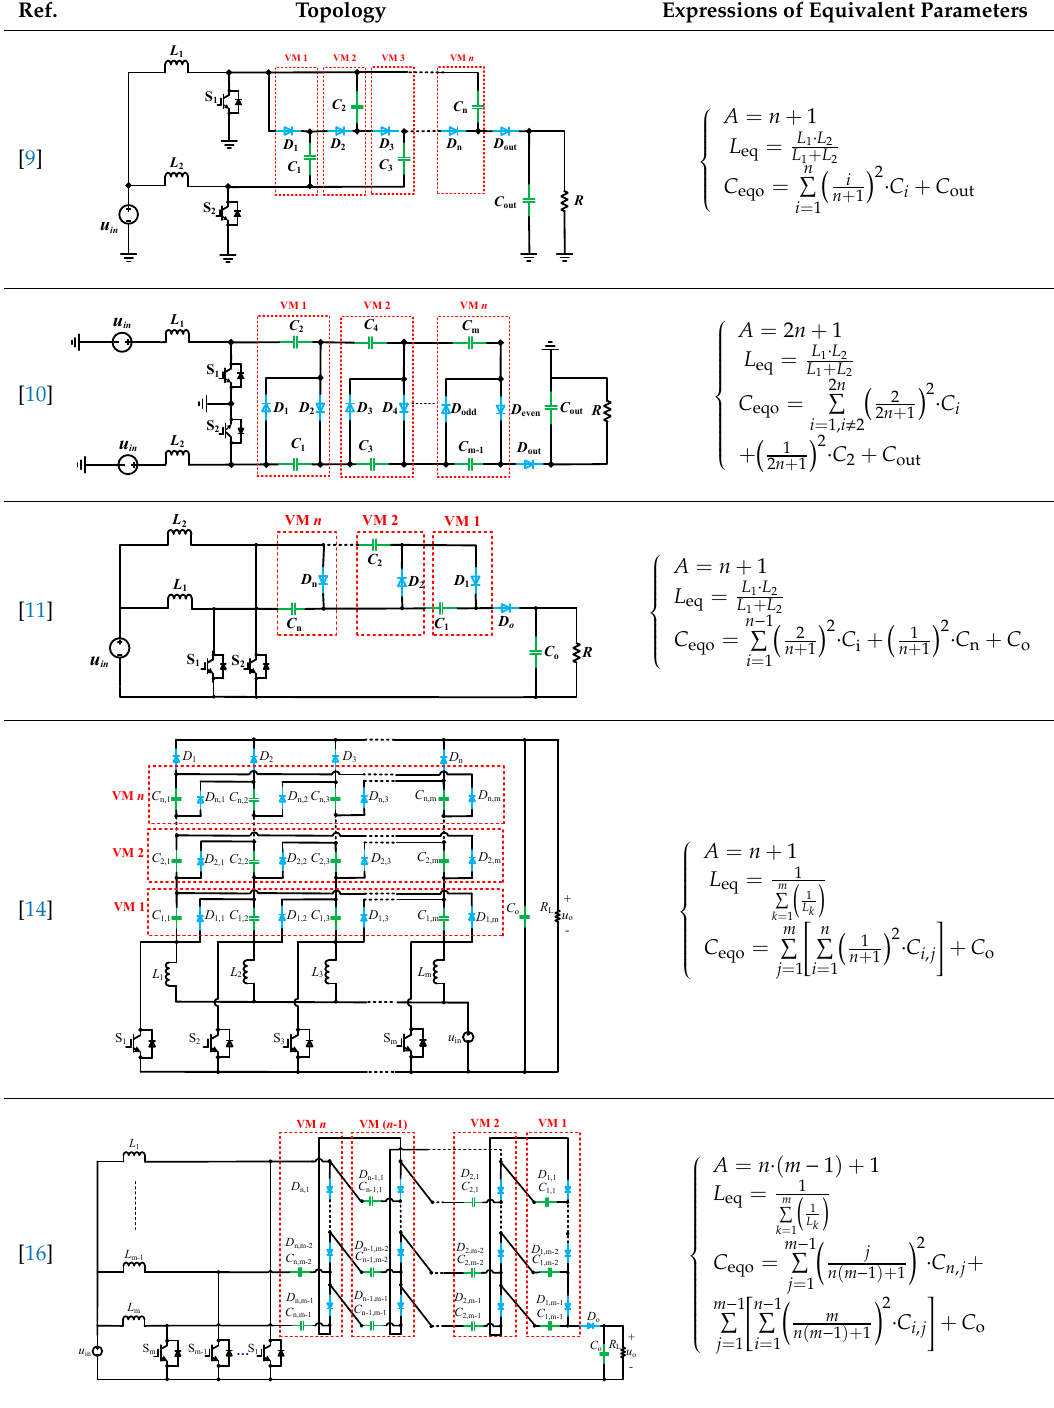
Table 1. Parameters of the reduced-order average model for different converter circuits based on VM. Ref.